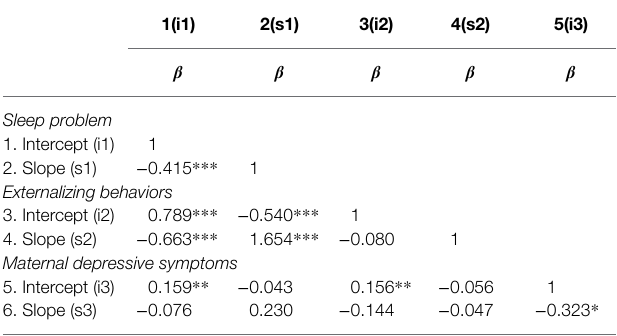
TABLE 4 | Coefficients among growth factors in multivariate growth model 1: sleep duration—externalizing behaviors.